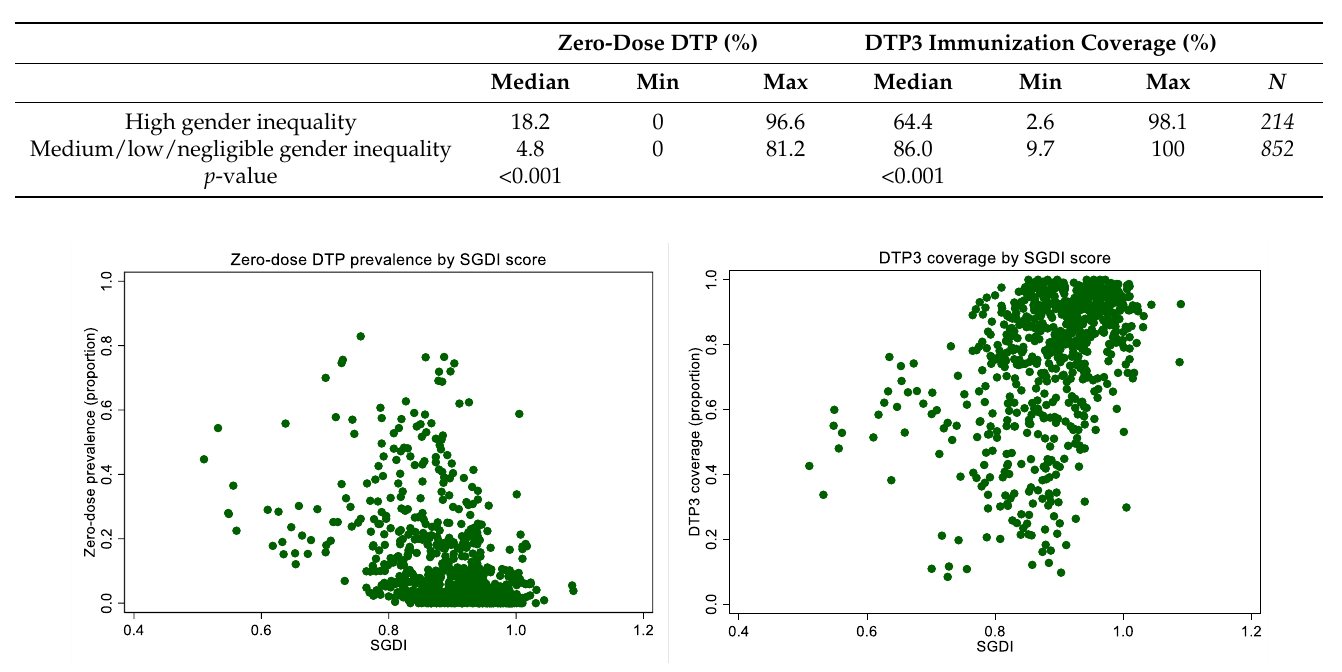
Table 2. Prevalence of zero-dose DTP and DTP3 immunization coverage by SGDI category, most recent year of available data.